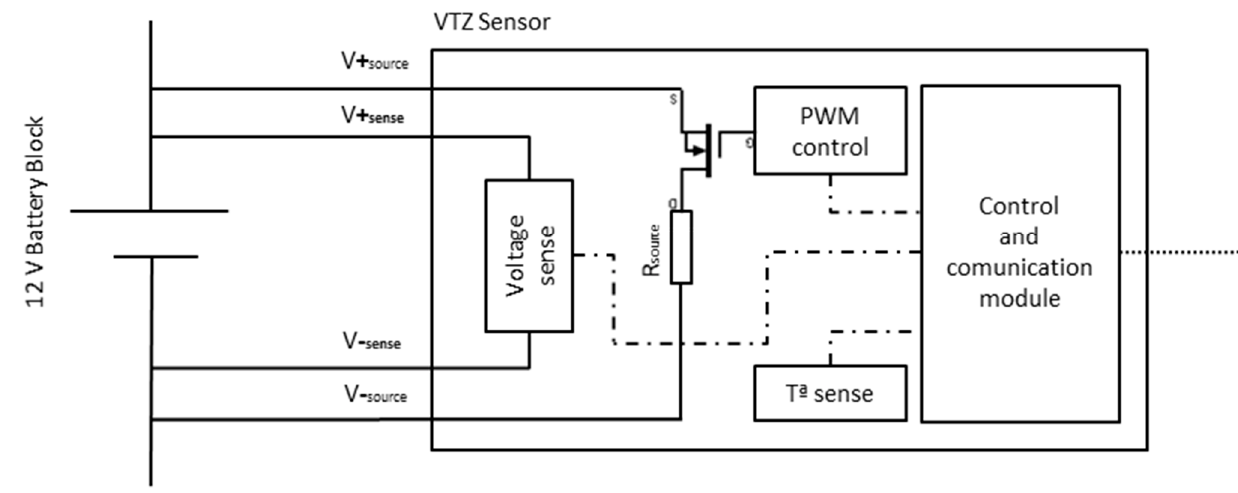
Figure 3. Block diagram of the VTZ sensor. Table 1. Accuracy of the VTZ